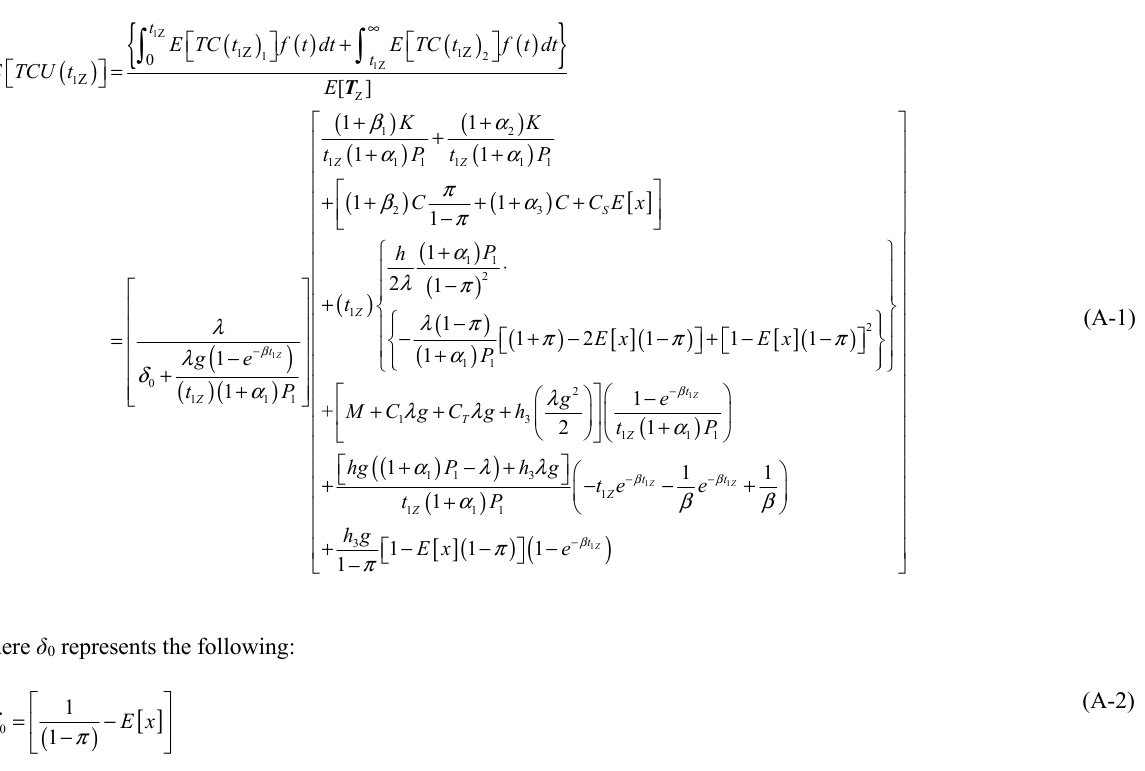
Fig. 19. The critical outsourcing cost-added factor β 2 on the ‘pure make’